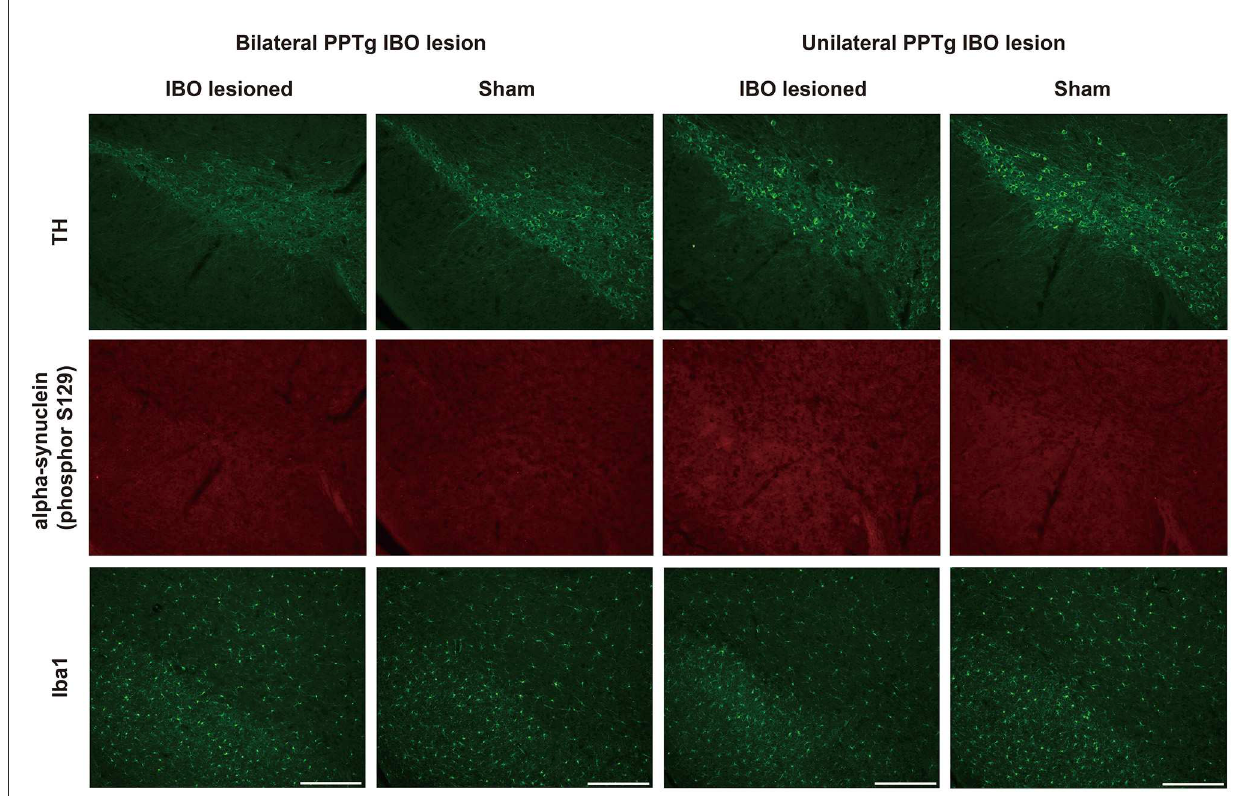
FIGURE7 No neurodegeneration and microglial response were observed in the SNpc after the PPTg IBO lesion. Representative photographs of dopaminergic neurons, no fluorescence signal of alpha-synuclein (phosphor S129), and absent microglial response in the SNpc at AP − 2.79mm. Scale bar = 1000 µ